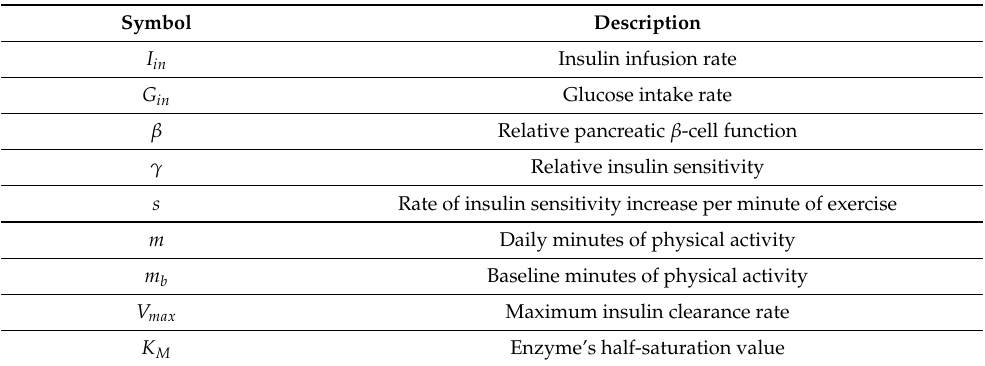
Table 1. Parameters of the glucose and insulin compartment models. Symbol